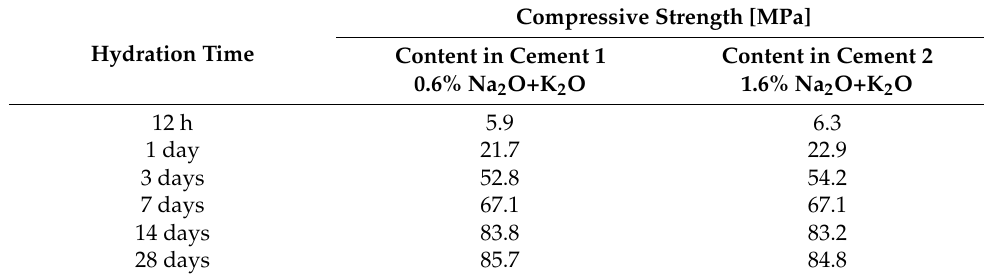
Table 2. Influence of alkalis on the strength of Portland cement